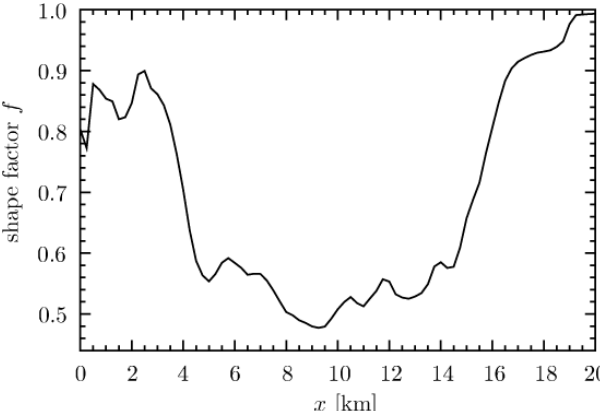
Fig. 1. Evolution of the shape factor f along the central flow line for the 1973 surface